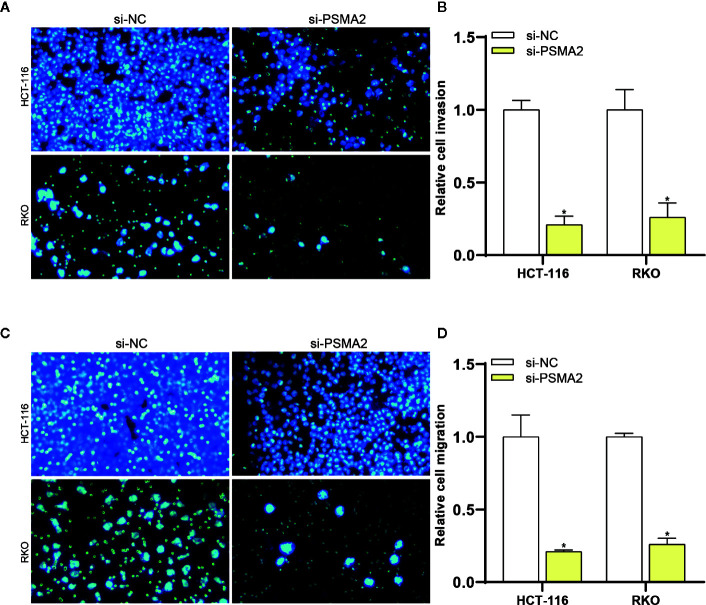
PSMA2 promotes CRC cell migration and invasion. (A, B) The migratory capacity of RKO or HCT-116 cells was inhibited after silencing PSMA2. (C, D) The invasive capacity of RKO or HCT-116 cells was inhibited by PSMA2 silencing. *P < 0.05.